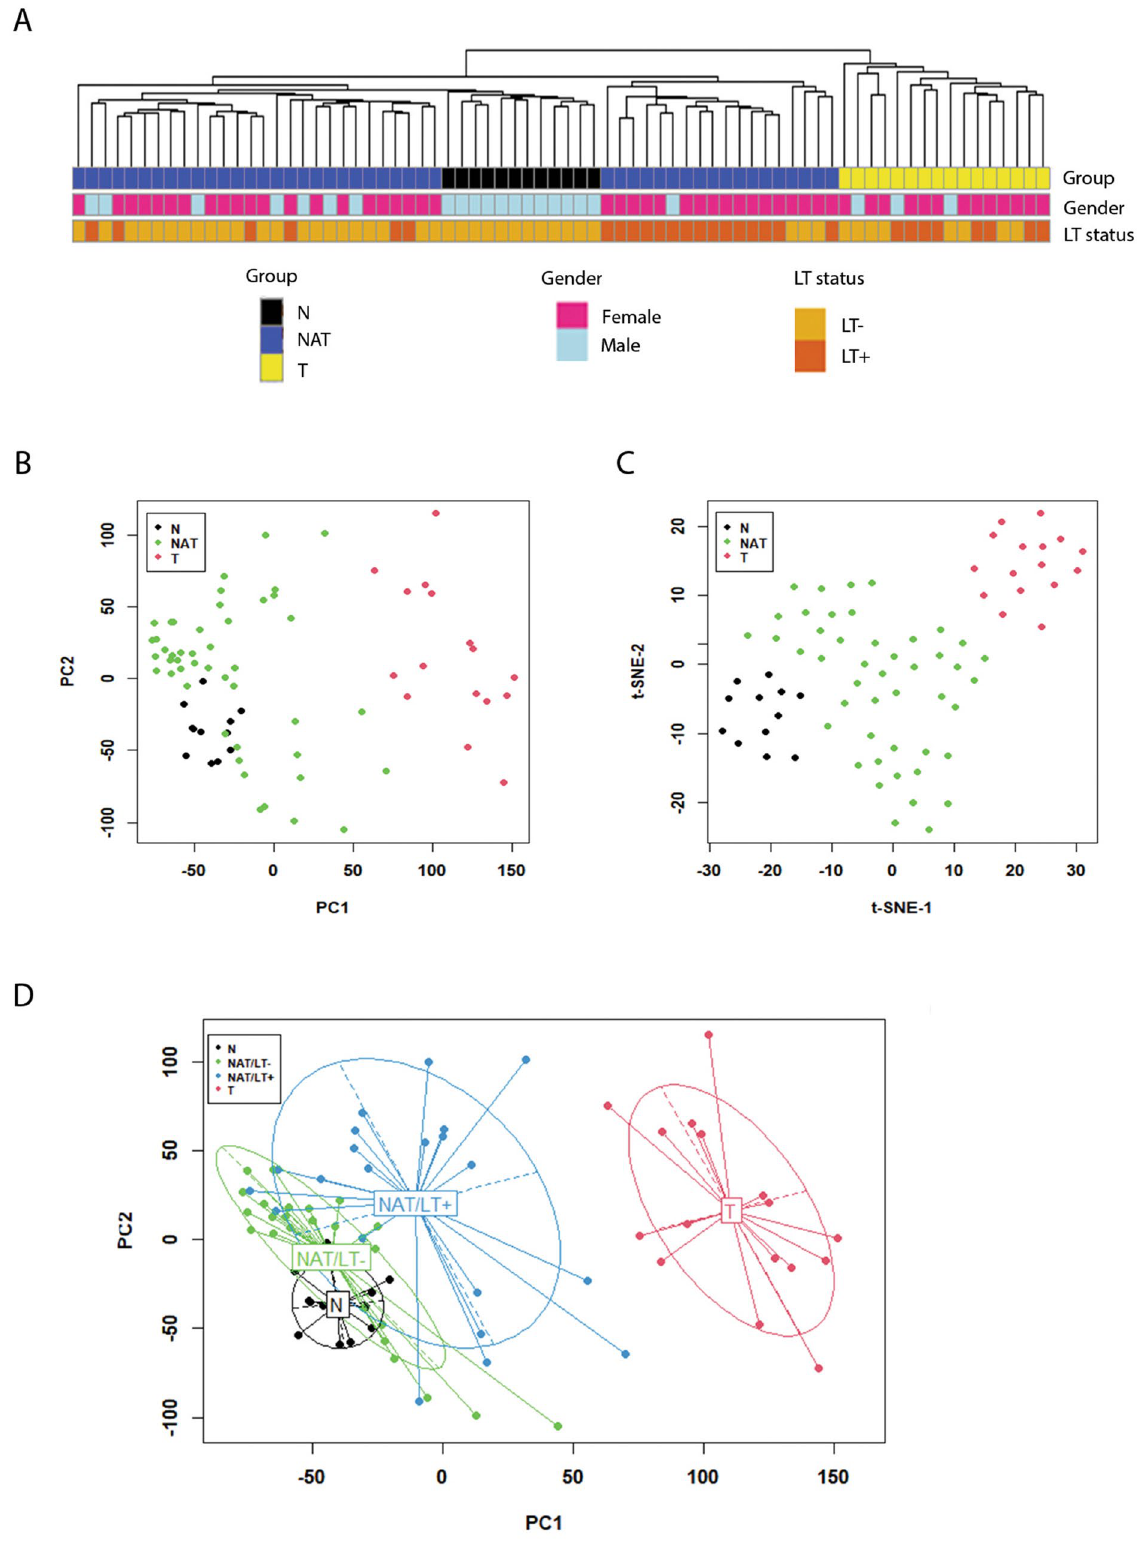
Figure 1. Gene expression patterns and correlation with clinical information. ( A ) Sample clusters. Euclidean distance and average linkage clustering method was used. Gender and the presence of lymphocytic thyroiditis (LT) in each sample are marked with color bars. ( B ) Plot of principal component analysis. ( C ) t-SNE plot. ( D ) Principal component analysis with confidence ellipses according to tissue type. A total of 22,411 genes after filtering were included in the analysis. All the plots were created with log transformed normalized gene expression